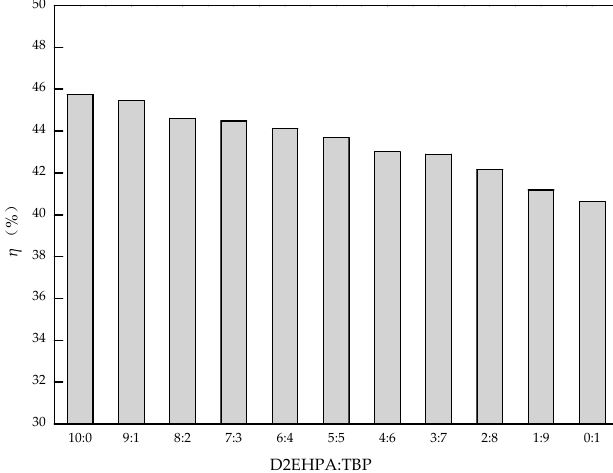
Figure 1. Effect of different ratios of D2EHPA to TBP on impregnation ratios.